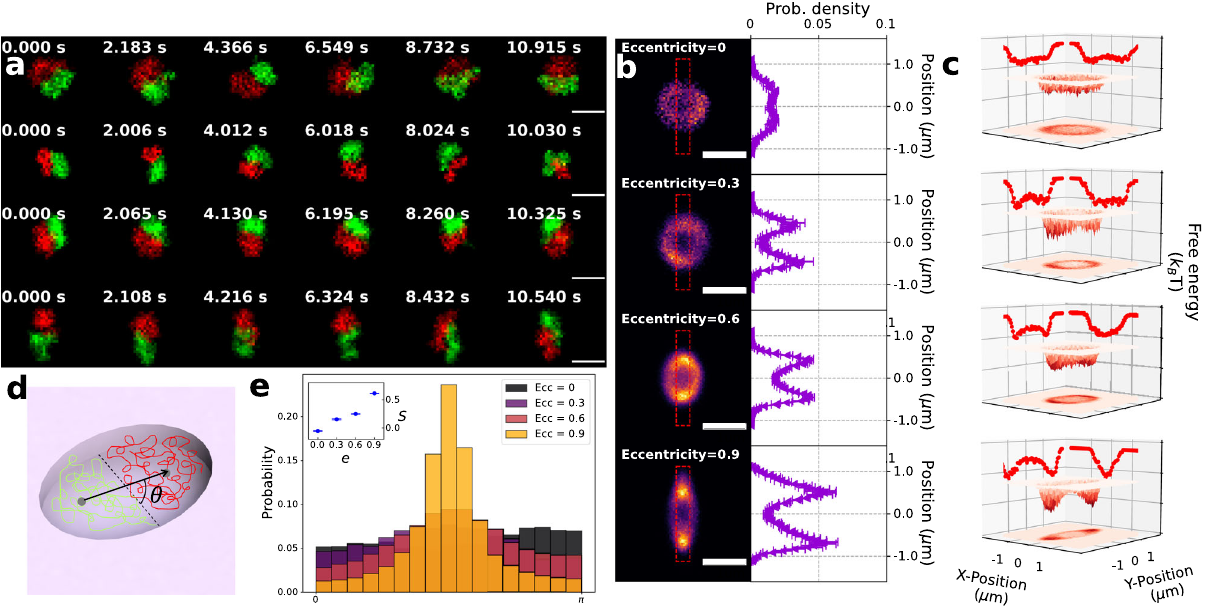
Fig. 2 Experimental results and equilibrium analysis for two cavity con fi ned DNA chains of equal size. a Montage of fl uorescence images of two λ -DNA molecules con fi ned in elliptical cavities with varying eccentricity (the eccentricity values, ranging top to bottom, are 0.0, 0.3, 0.6 and 0.9). The scale bars are 2 μ m and the time lapse between consecutive images is about 2 s. b Probability of fi nding a chain center at certain position within the cavity. The cross- section of the probablity density distribution, labeled with red dashed box, is shown next to the heatmap.The error bars denote the standard deviation of the probability density. c Free energy landscape within the cavity. The red lines indicate the projection of the landscape along the corresponding direction. d A cartoon giving the de fi nition of the separation vector and θ . e The resultant θ -distribution for cavities of varying eccentricity. The inset shows the extracted order parameter. The error bars denote the standard error of the